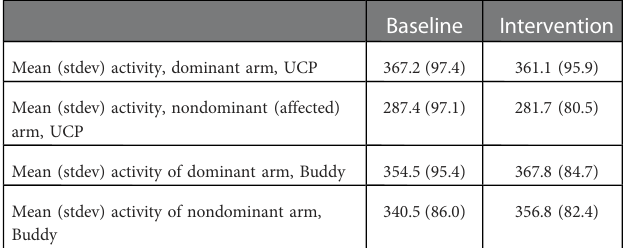
TABLE 2 Summary statistics of arm activity corrected for time worn (minutes) in the baseline and intervention periods.